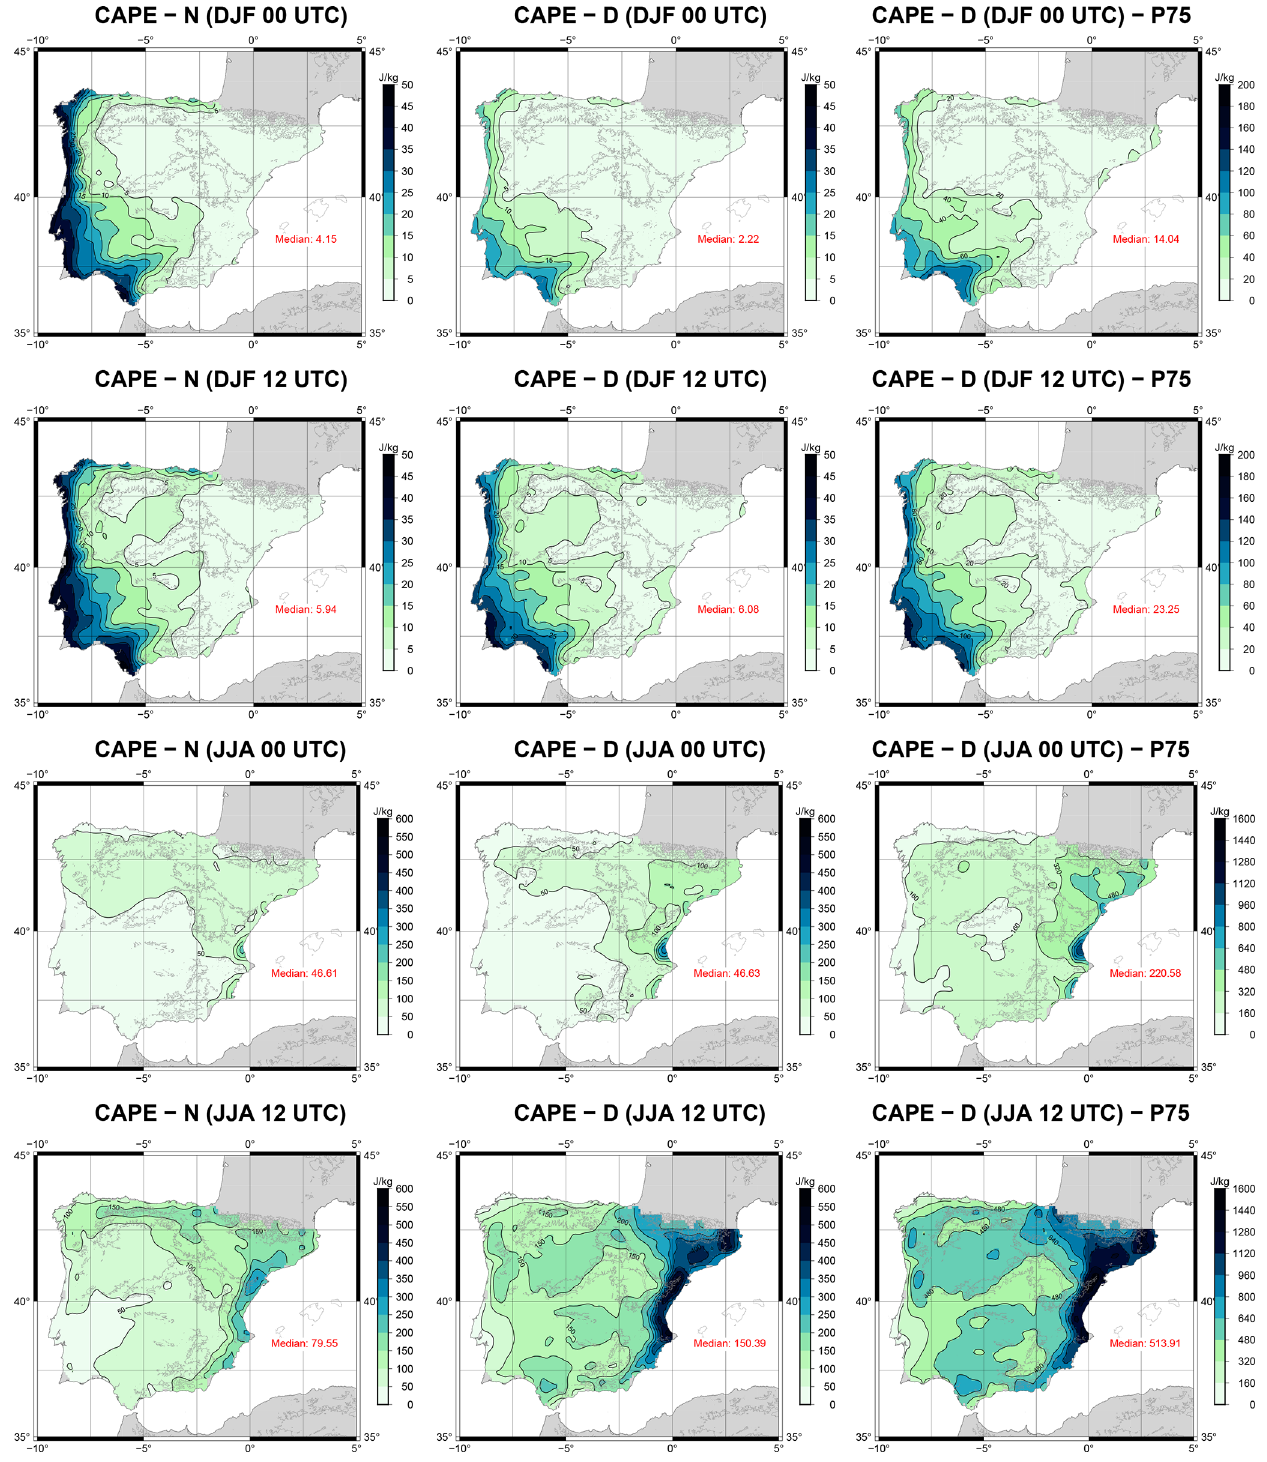
Figure 9. Same as Fig. 8 but for CAPE. The rightmost column (P75) shows the spatial distribution of the mean values of CAPE in the D experiment for those days on which CAPE is higher than the third quartile of the sample of CAPE at every grid point.